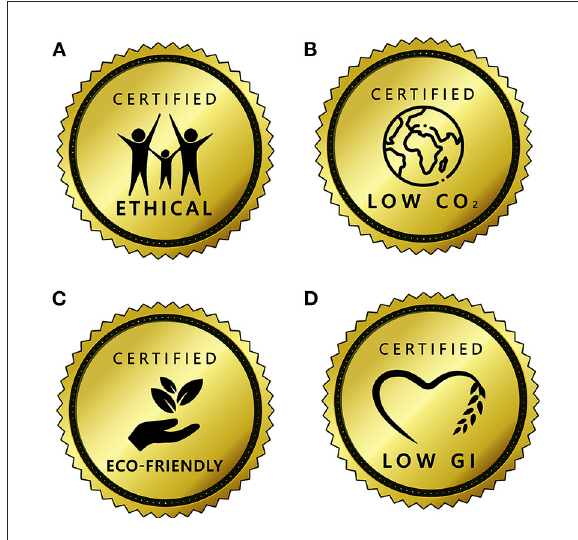
FIGURE1 Examples of certification labels representing (A) ethical, (B) low-emission, (C) eco-friendly, and (D) low-glycemic index